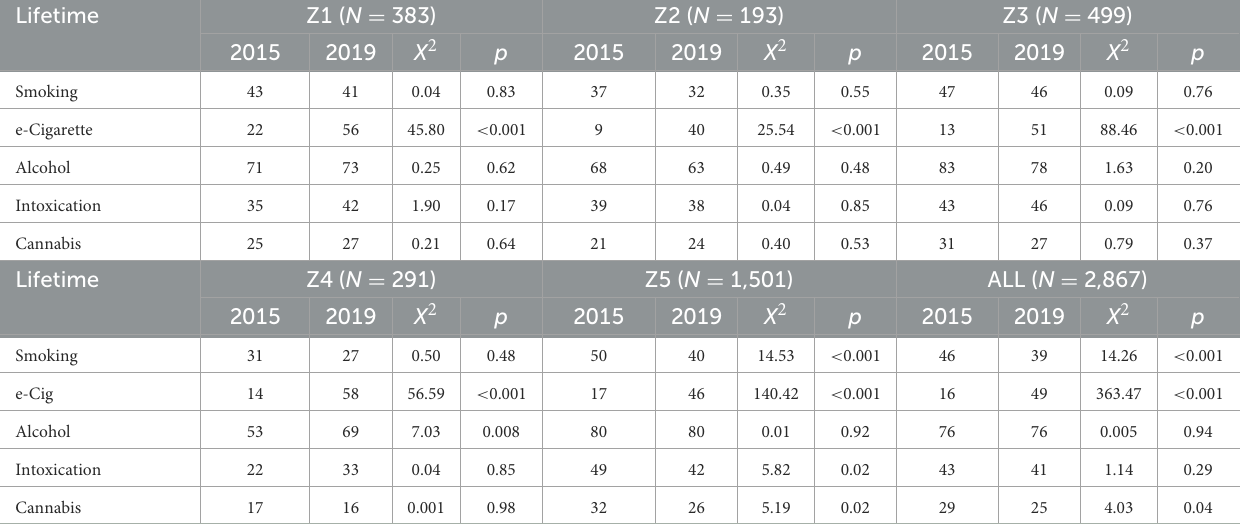
TABLE 1 Comparison of lifetime substance use in Tarragona City using Chi-square tests, 2015–2019. Lifetime